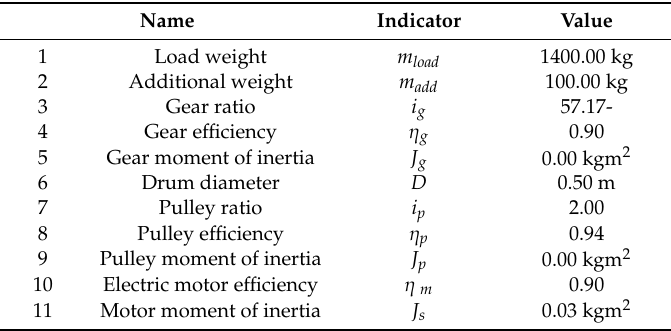
Table 2. Input data for calculations of the motor selection for crane hoist drive.